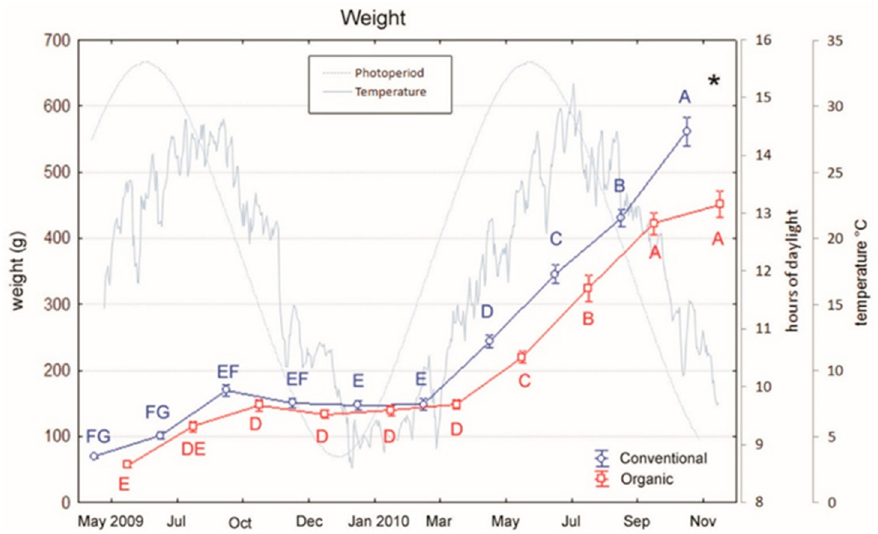
Figure 1. Variations in weight of sea bass over an 18-month period (mean ± SE) reared under conventional and organic aquaculture. Di ff erent letters indicate significant di ff erences in samplings within the same feeding system (organic or conventional; p < 0.05). Asterisk indicates significant di ff erences between feeding systems (organic vs. conventional) within the same sampling ( p < 0.05). In all the ponds, stocking density was the same (initial stocking density: 2 kg / m 3 ; 10,000 fish per pond), as all the other parameters (water temperature and photoperiod, both environmental). The dissolved oxygen was kept at normoxic conditions for European sea bass ( > 7.5 mg / L) as recommended by EFSA (European Food Safety Authority) [40] and ranged from 8 to 12 mg / L in both ponds. Fish of the two groups were fed with di ff erent types of diet, one certified organic and one conventional Table 1. Overall mortality at the end of the trial in both the ponds was 15% and final densities were 12 and 14 kg / m 3 for organic and conventional groups,